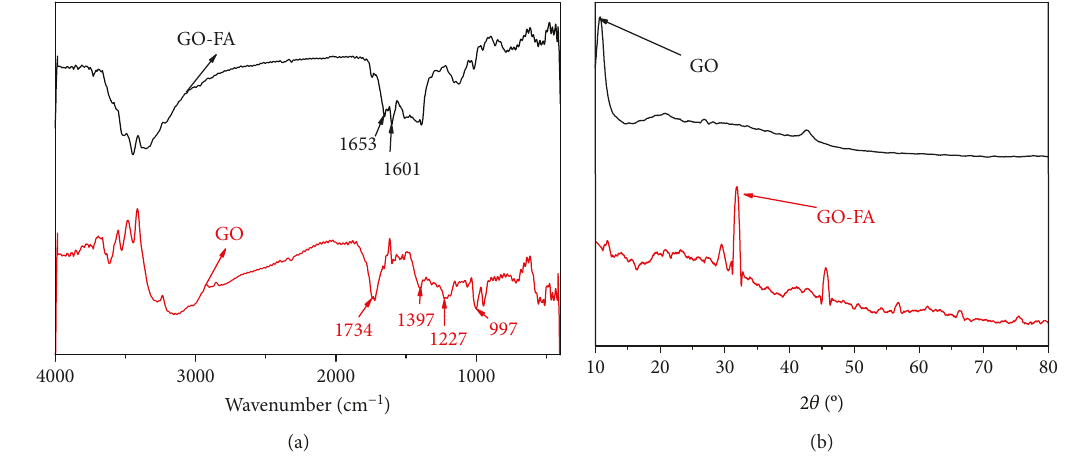
Figure 2: IR spectra (a) and XRD spectra (b) of GO and GO-FA.